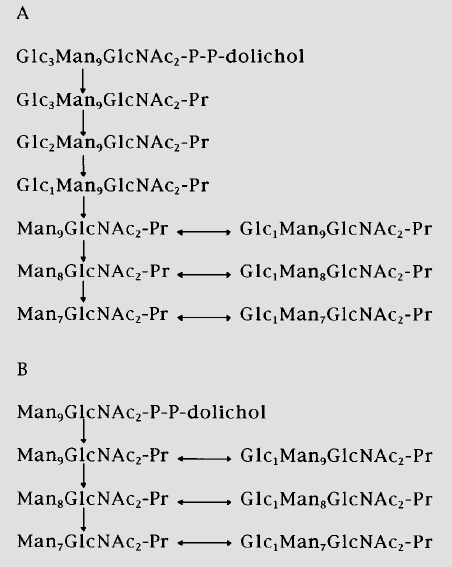
Figure 2 - Processing of N- linked oligosaccharides. The processing reactions occurring in the endoplasmic reticulum of mammalian, plant and fungal (A) or T. cruzi (B) cells is shown. Pr stands for